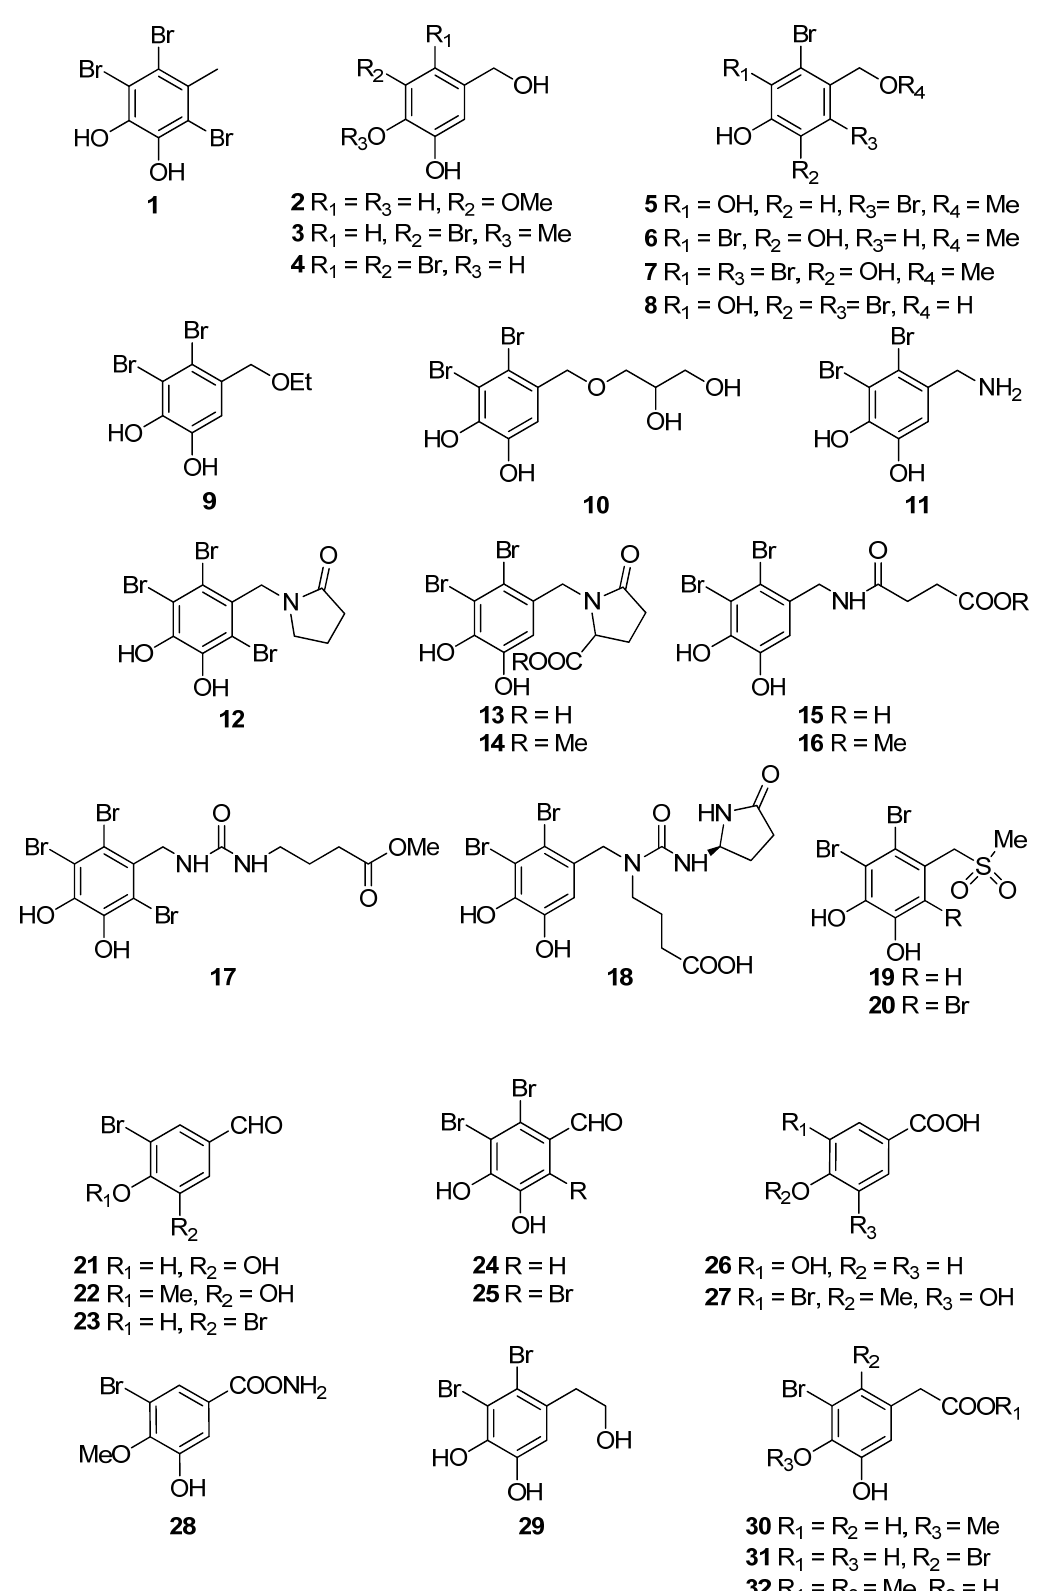
Figure 2. Chemical structures of compounds 1 – 32 .